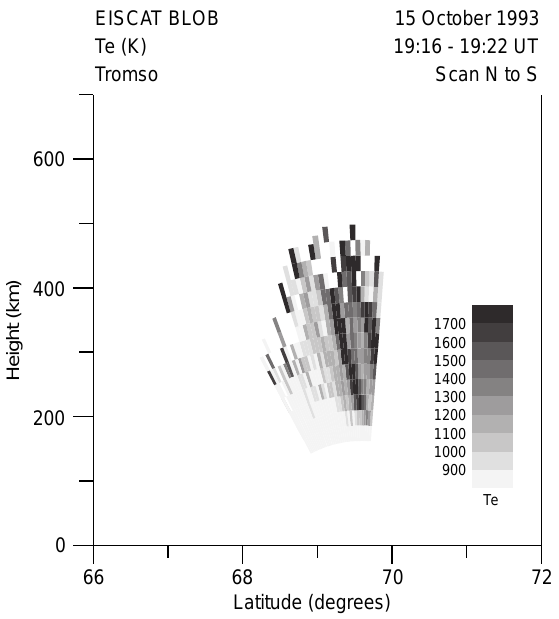
Fig. 7. Electron temperatures as a function of latitude and height measured by the radar during the scan between 1916 and